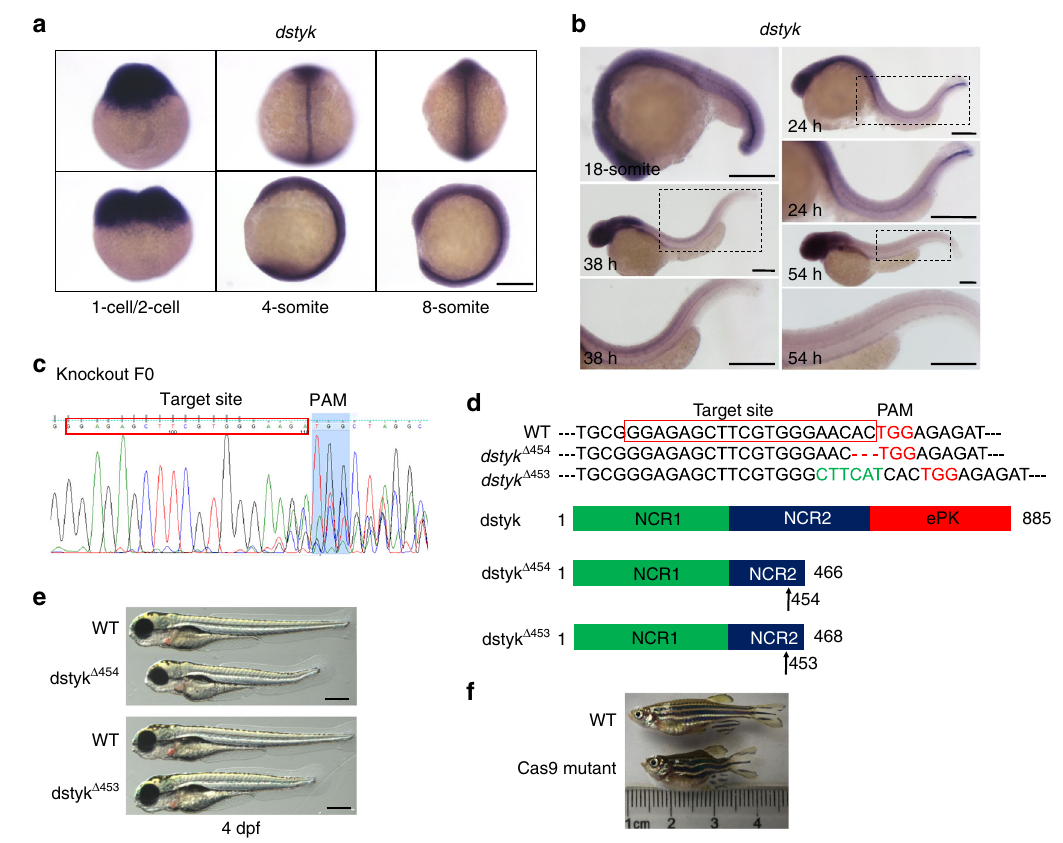
Fig. 3 Expression pattern of dstyk and knock out dstyk by CRISPR/Cas9. a Dstyk ISH at 1-cell/2-cell, 4-somite and 8-somite stage. b From 18-somite, 24 hpf, 38 hpf to 54 hpf, notochordal expression of dstyk was dynamically changed as detected by ISH. c The Cas9 target site for knockout dstyk gene worked in knock out F0 generation. d Top panel showed the DNA sequences for WT and two Cas9 mutant lines. TGG (red) is the PAM sequence. Deletion is represented by a red dashed line and insertion is highlighted in green. Bottom panel diagramed DSTYK protein structures of WT and predicted mutants. Arrows indicate amino acid at the mutation site. e Bright- fi eld images showing the WT and two Cas9 mutant lines at 4 dpf. f Cas9 mutant lines showed similar scoliosis phenotypes with smt mutant. Scale bar represent 200 μ m in ( a and b ), 400 μ m in ( e zebra fi sh dstyk mRNA or human DSTYK mRNA injection